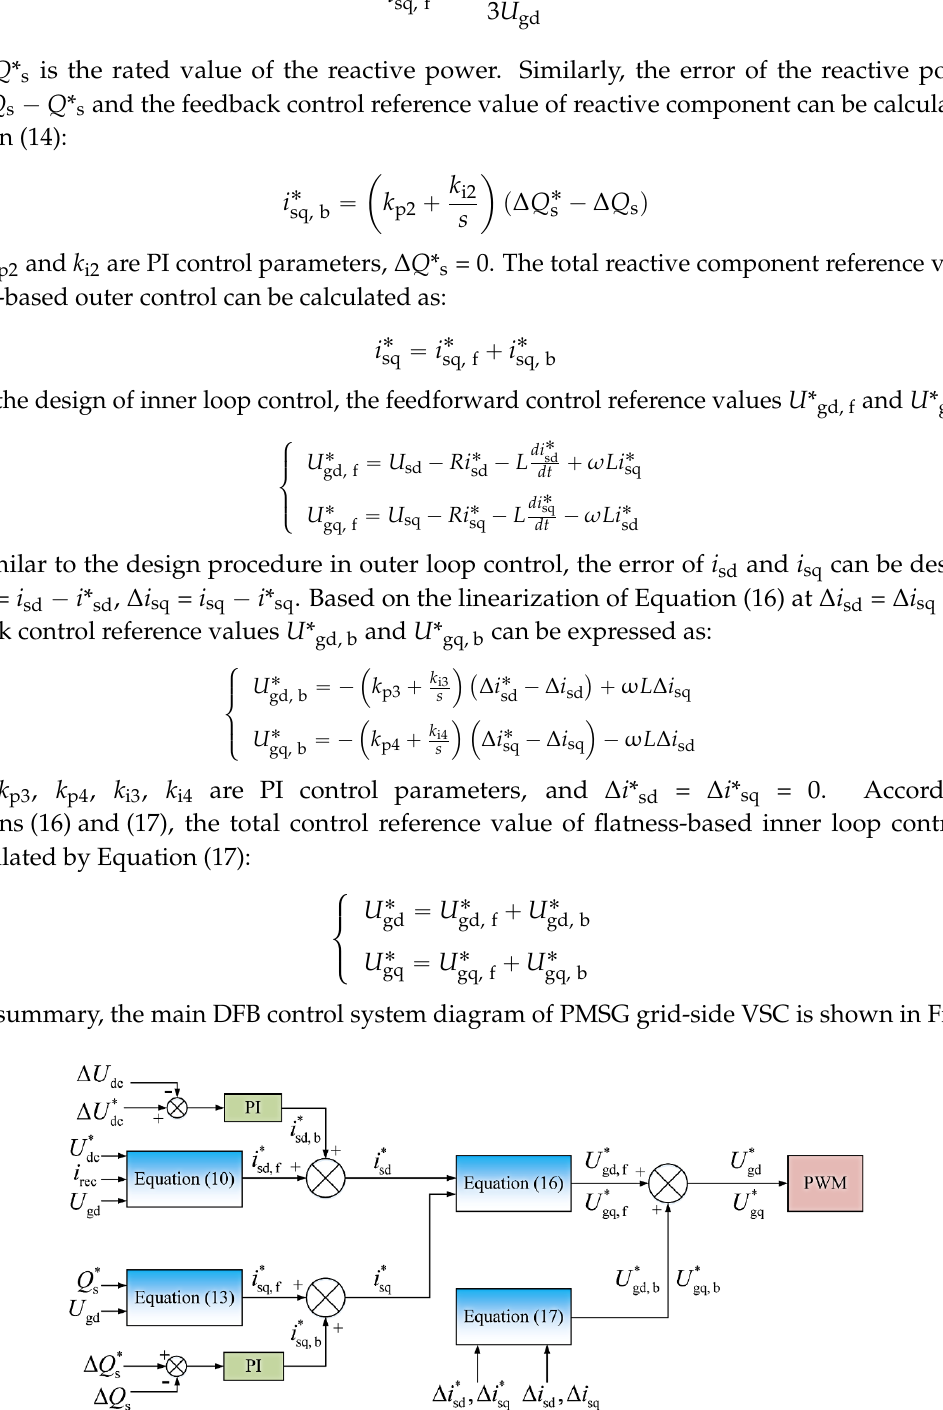
Figure. 3. DFB control system diagram of a PMSG grid-side voltage source converter (VSC). Figure 3. DFB control system diagram of a PMSG grid-side voltage source converter